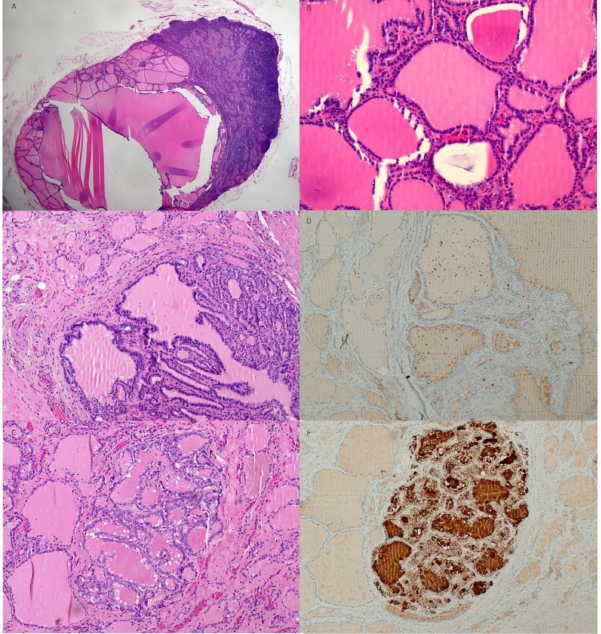
Figure 4. Histologic features of the cervical lymph nodes and thyroid gland. ( A ) A cervical